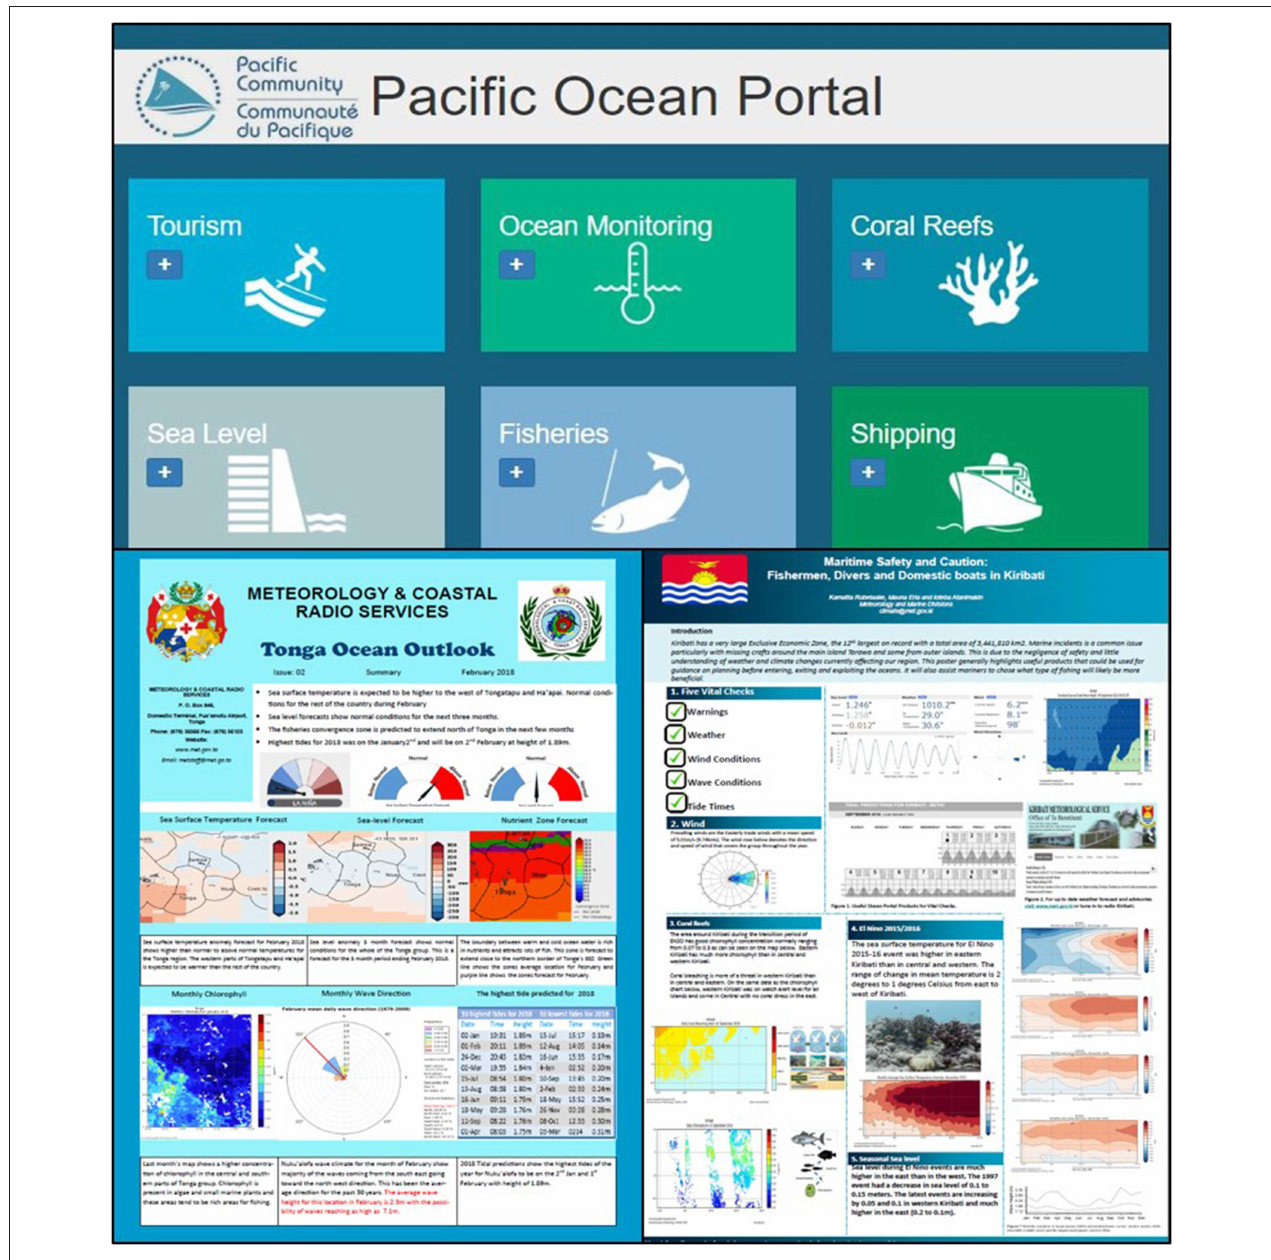
FIGURE 1 | (Top) landing page of the Pacific Ocean Portal http://oceanportal.spc.int ( Bottom left) Monthly Ocean Outlook produced by Tonga Meteorological Service (Tonga Meteorological Service (TMS), 2018) and ( Bottom right) an Ocean Science for Maritime Safety and Caution poster produced by Kiribati stakeholders at the Fiji Sub-regional Workshop in 2016 (Eria et al.,